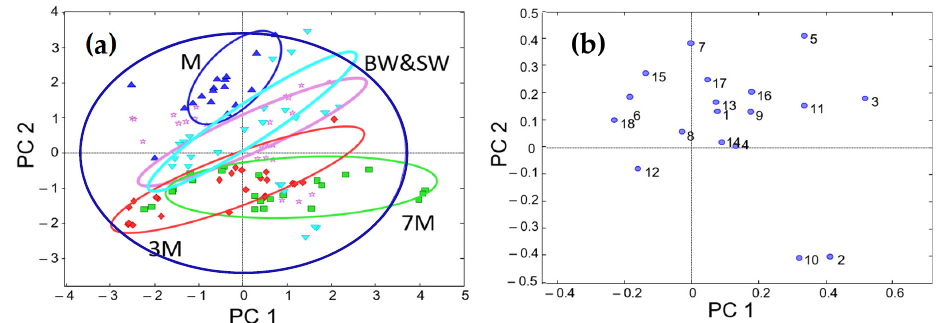
Figure 2. Plots of scores ( a ) and loadings ( b ) from mid-level data fusion. Sample assignment: M = must (blue); BW = base wine (light purple); SW = stabilized wine (light blue); 3M = sparkling wine with 3 months of aging (red); 7M = sparkling wine with 7 months of aging (green). Variable assignment: 1–9 = 1–9 PC of biogenic amines PCA; 10–18 = 1–9 PC of elemental composition PCA.